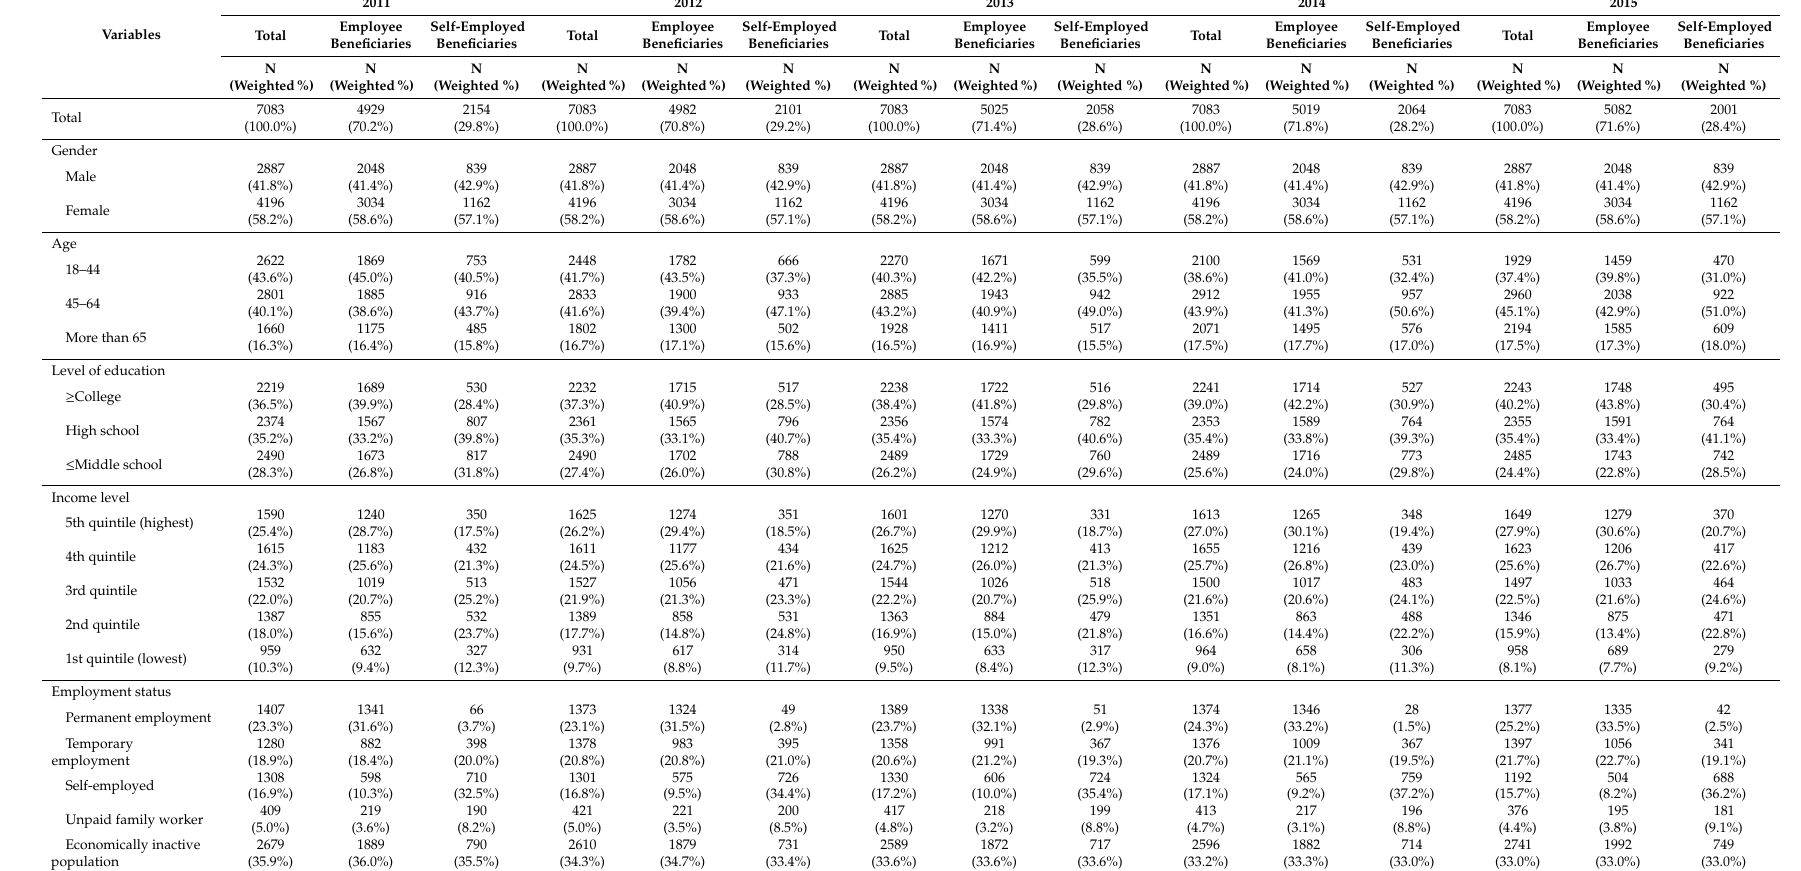
Table A1. General characteristics of Korean adults aged 18 + according to health insurance type,